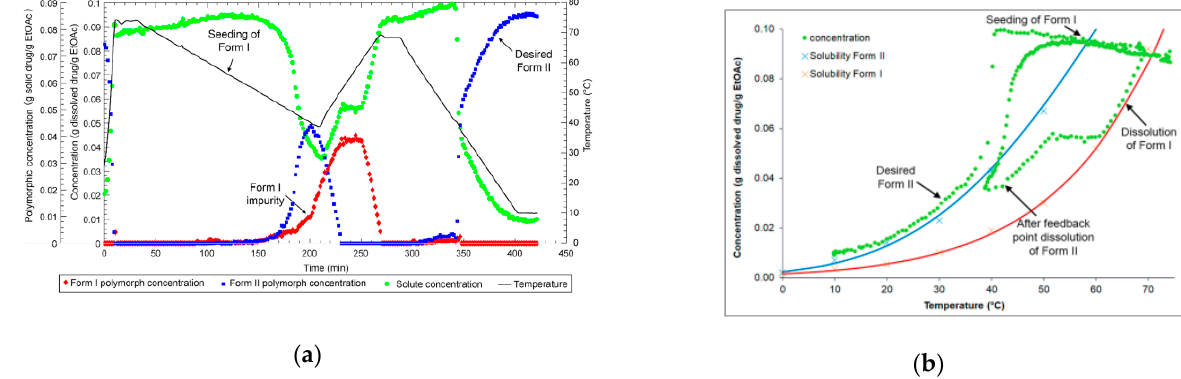
Figure 7. The target crystal form is Form I: concentration and temperature profiles ( a ); crystallization phase diagram during the polymorph concentration control (PCC) process ( b ). (Caption and figure reprinted with permission from Reference [36]).